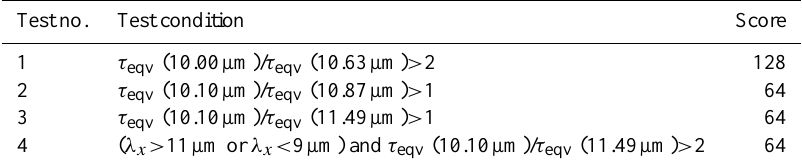
Table 2. FOV dust likelihood score test, the final score is the sum of the scores of all positive tests. Only FOVs with scores higher than 250 are used for dust retrieval. λ x denotes the wavelength corresponding to the maximum brightness temperature ( T base ). Test no.